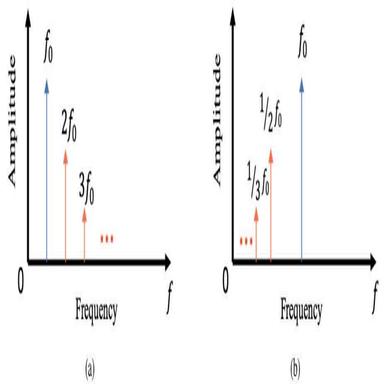
Spectrum characteristics of nonlinear elastic wave modulation methods: (a) NWMS, (b) Wave mixing, (c) NRUS.